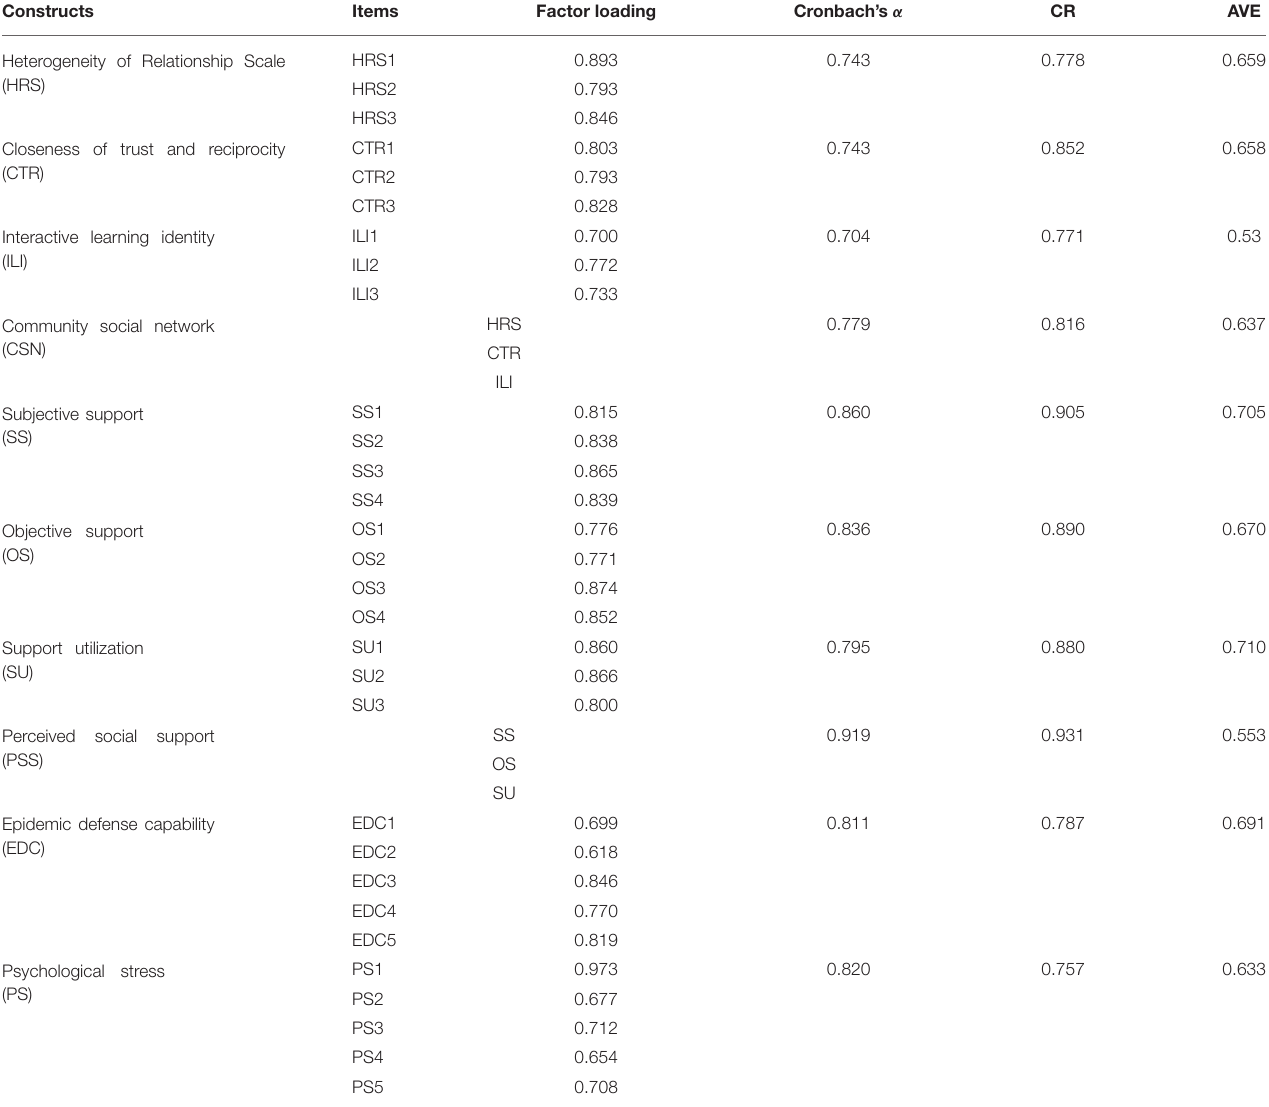
TABLE 2 | Results of